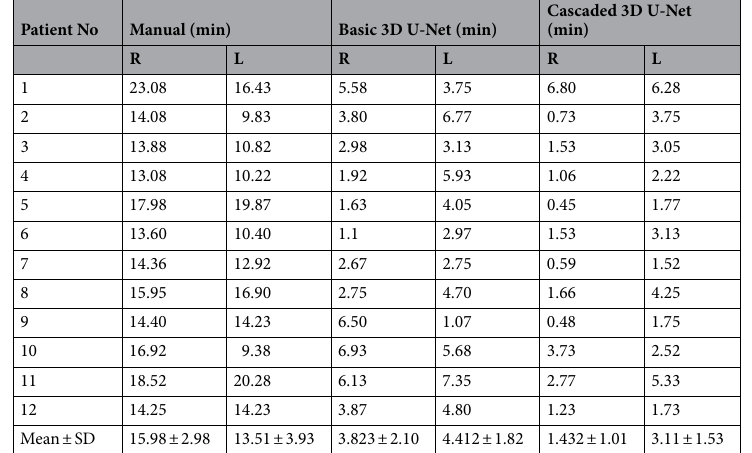
Table 4. Segmentation time for manual, basic 3D U-Net, and cascaded 3D U-Net in Stage